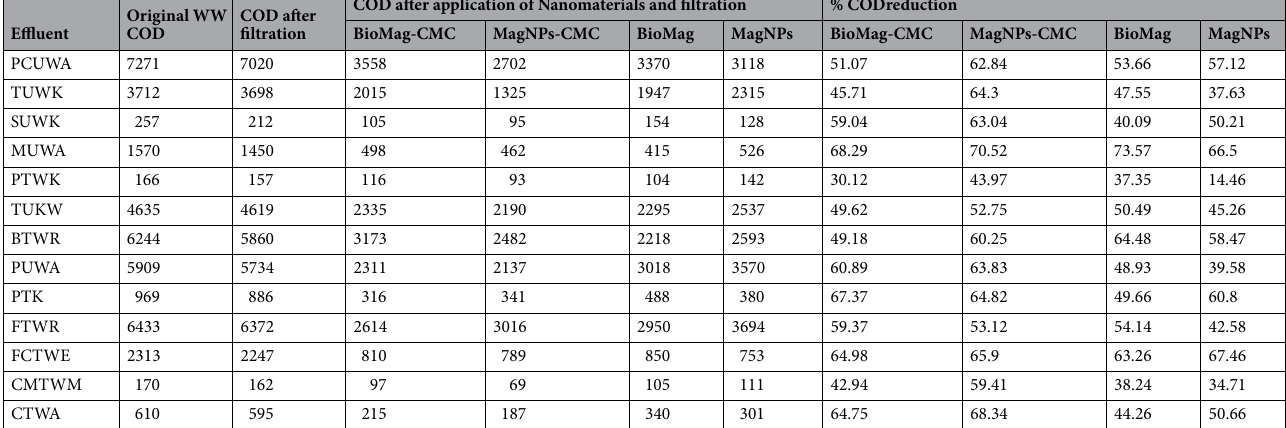
Table 4. Ranges of COD analysis obtained at the 13 study sites with their percentage reductions.